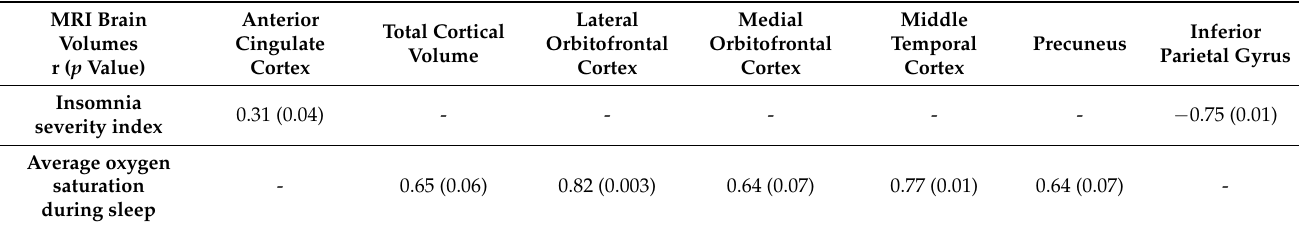
Table 2. Correlations between insomnia, sleepiness and oxygen during sleep with brain